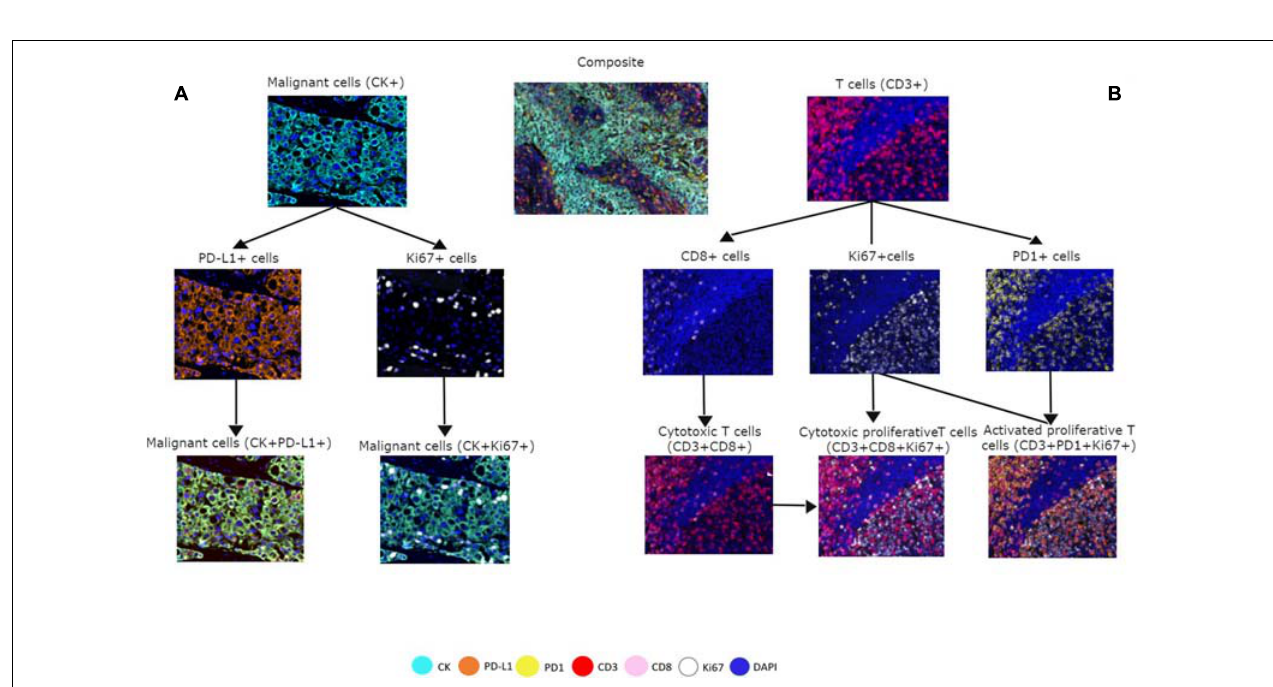
FIGURE 3 | Multiplex immunofluorescence panel showing different cell phenotype co-localizations in tumor and immune cells from a non-small cell lung cancer sample. (A) Marker expression of malignant cells with cytokeratin (CK) and co-localization with PD-L1 + and Ki67 +. (B) Marker expression of CD3 + on immune T-cells, expression of CD8 + cells, expression of PD-1 + cells, and co-localization with CD3 + CD8 + for cytotoxic T-cells, Ki67 + CD3 + CD8 + for cytotoxic proliferative T-cells, and CD3 + Ki67 + PD-1 + for activated proliferative T-cells. The composite image with all the markers is localized in the upper center of the